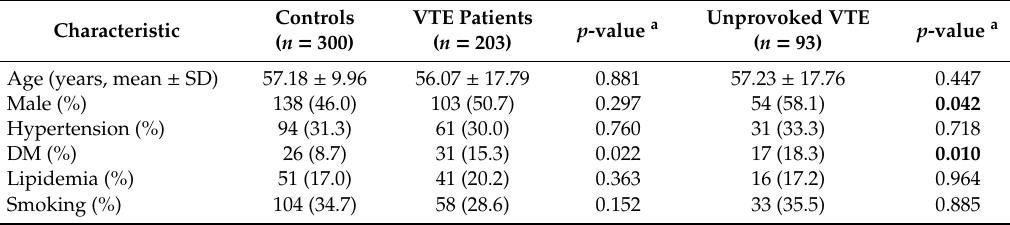
Table 1. Baseline characteristics of venous thromboembolism (VTE) patients and control